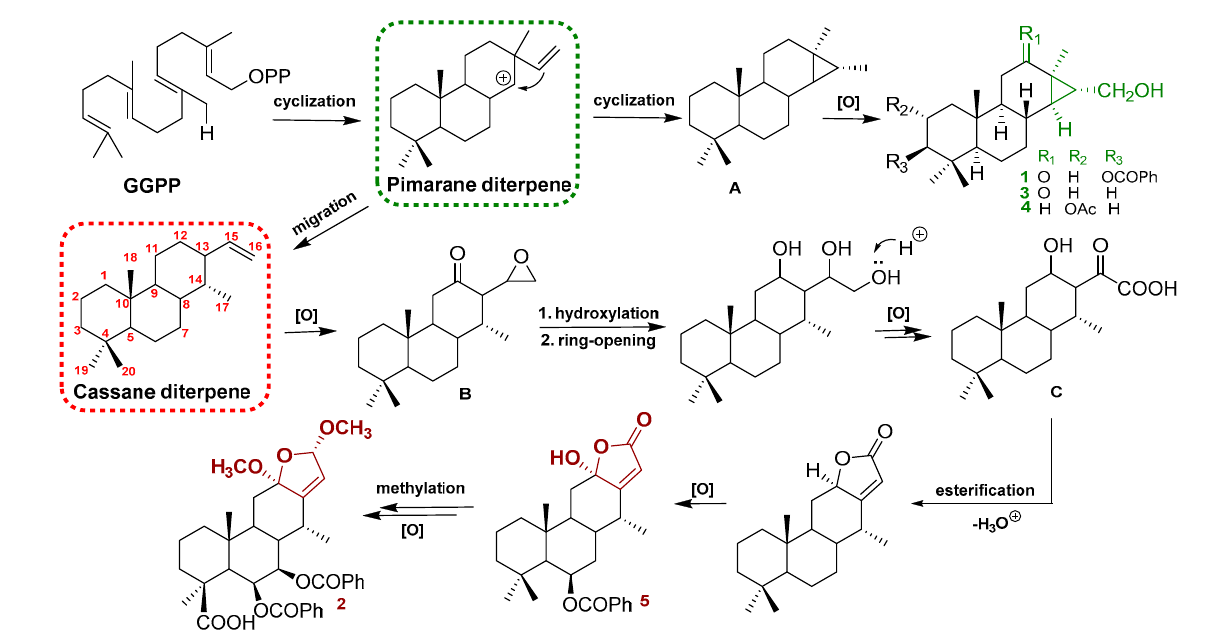
Figure 4. Plausible biogenetic pathways of compounds 1 – 5 .